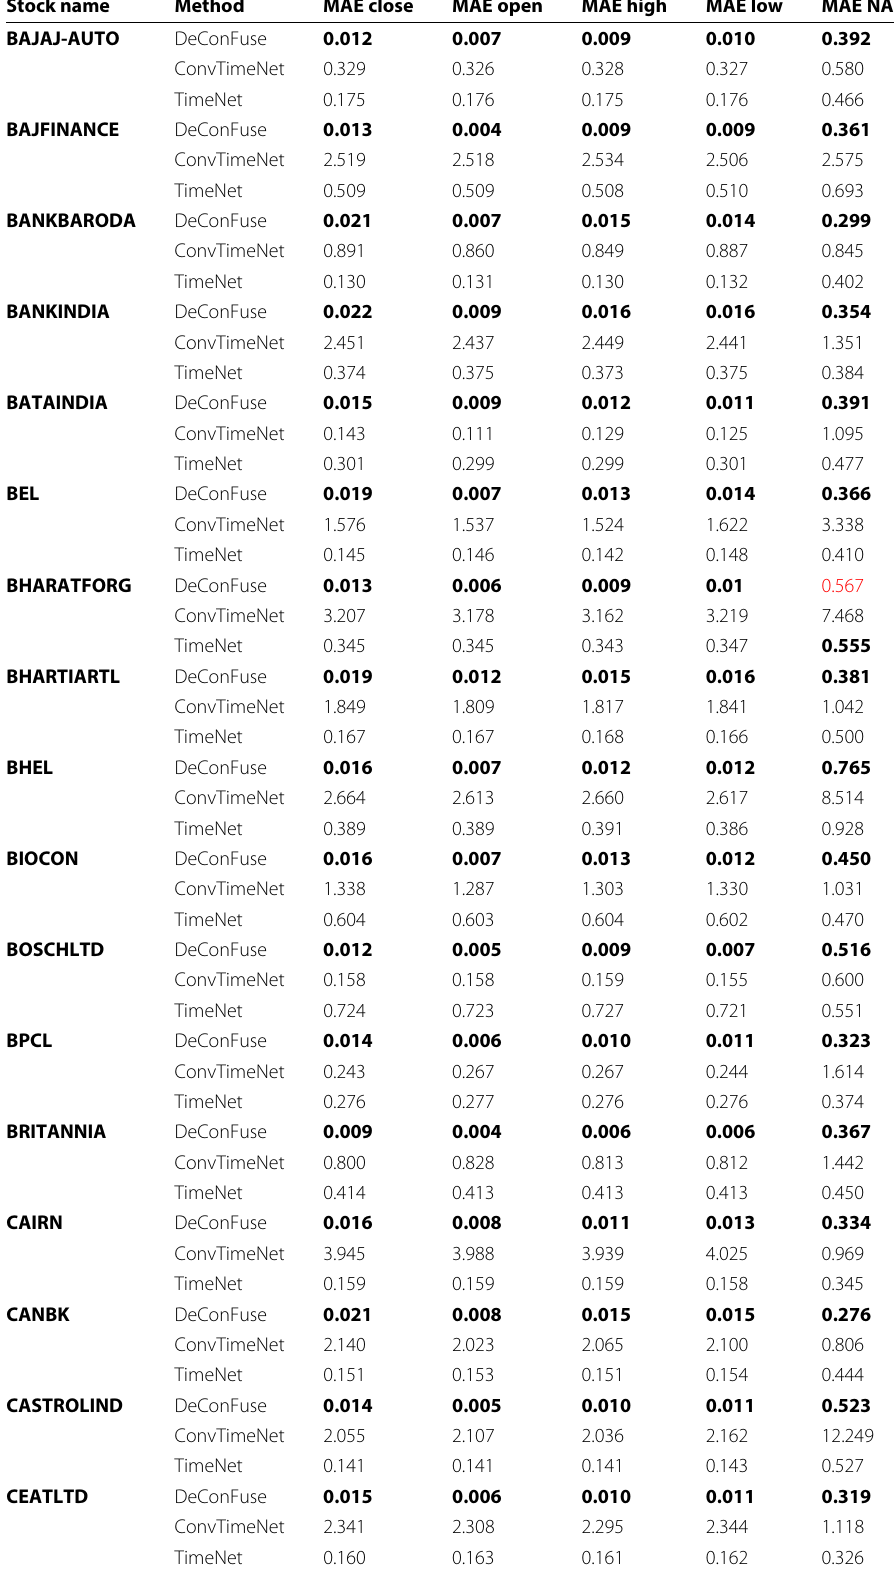
Table 5 Stock-wise forecasting results ( Continued